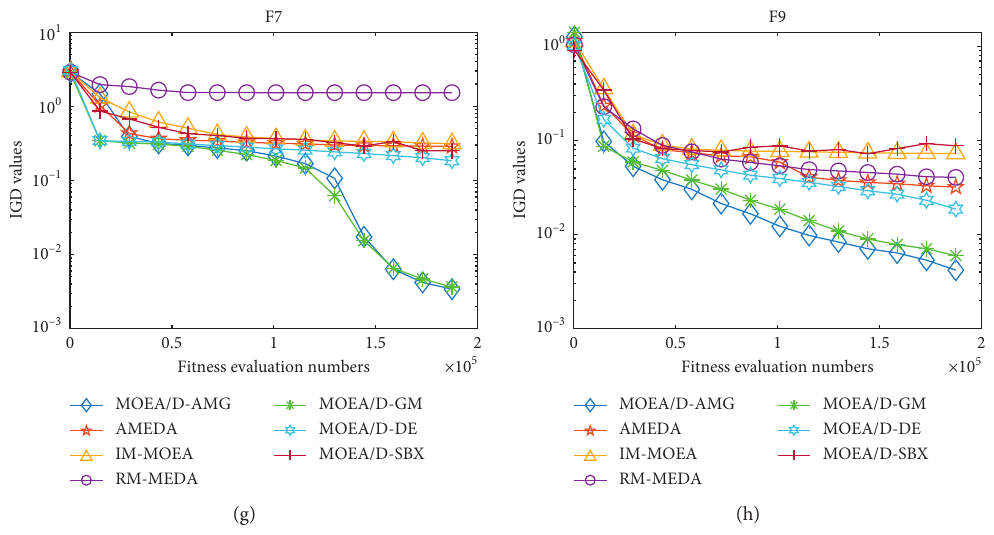
Figure 2: The convergence curves of all the compared algorithms on F1–F7 and F9.